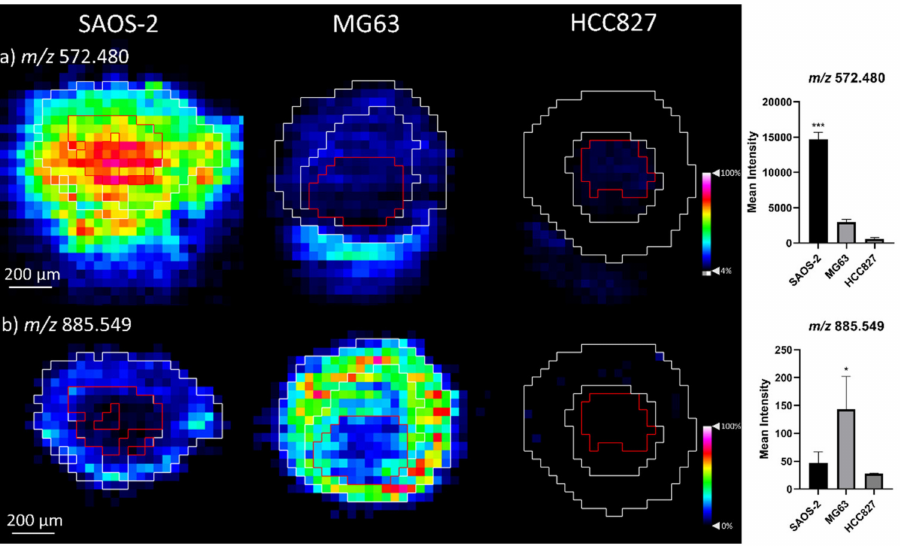
Figure 4. Distribution of metabolites significantly detected in OS aggregoid models. Ion density maps of metabolites outlining the core and outer area on the image. Mean intensity plotted on bar graph against the SAOS-2, MG63 and HCC827 aggregoids. Data is mean ± SD ( n = 3), one-way ANOVA with Tukey post hoc test * p < 0.05, *** p < 0.001. Scale bar 200 µ m. Peaks identified ( a ) m / z 572.480, Cer 34:1; O2 [M + Cl] − ; ( b ) m / z 885.549, PI